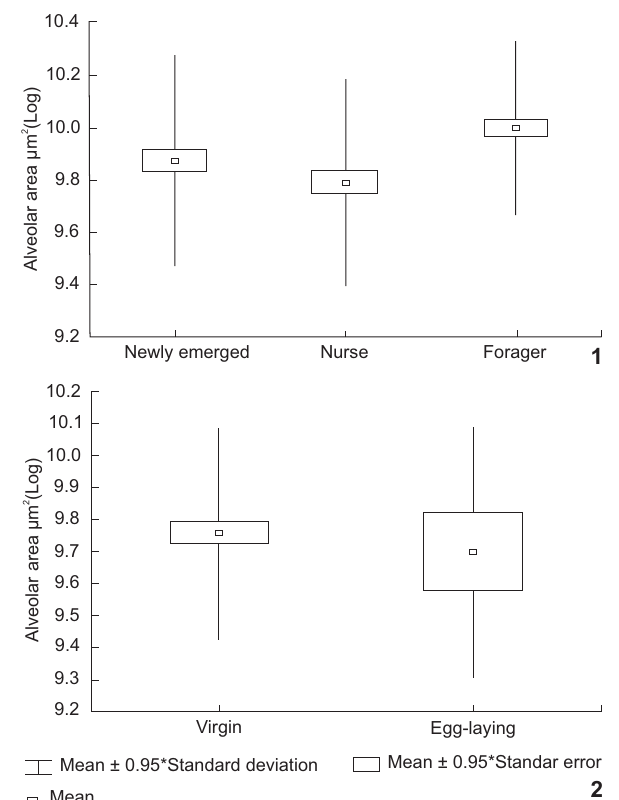
Figures 1-2. Graphs of alveolar average size in A. mellifera workers (1) and queens (2). Forager workers present the largest alveolar veolar